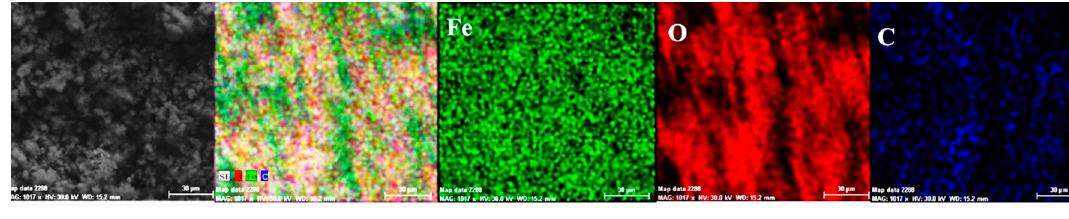
Figure 9. Elemental distribution on the surface of the crust of reaction products in the case of the C45/BSW system, after 85 days of immersion.